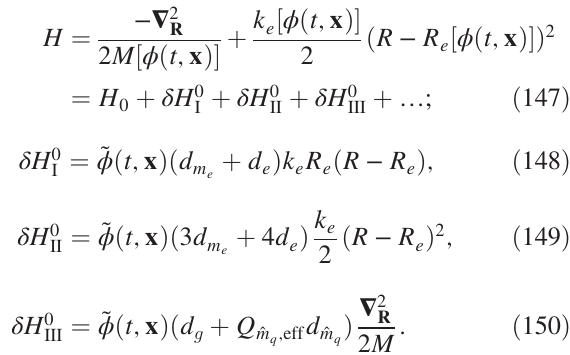
ð m þ m Þ . A neutral atom with nucleon number A and u d